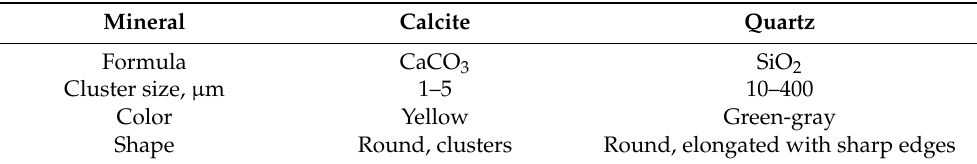
Table 4. Properties of minerals from exterior area and structural layer.